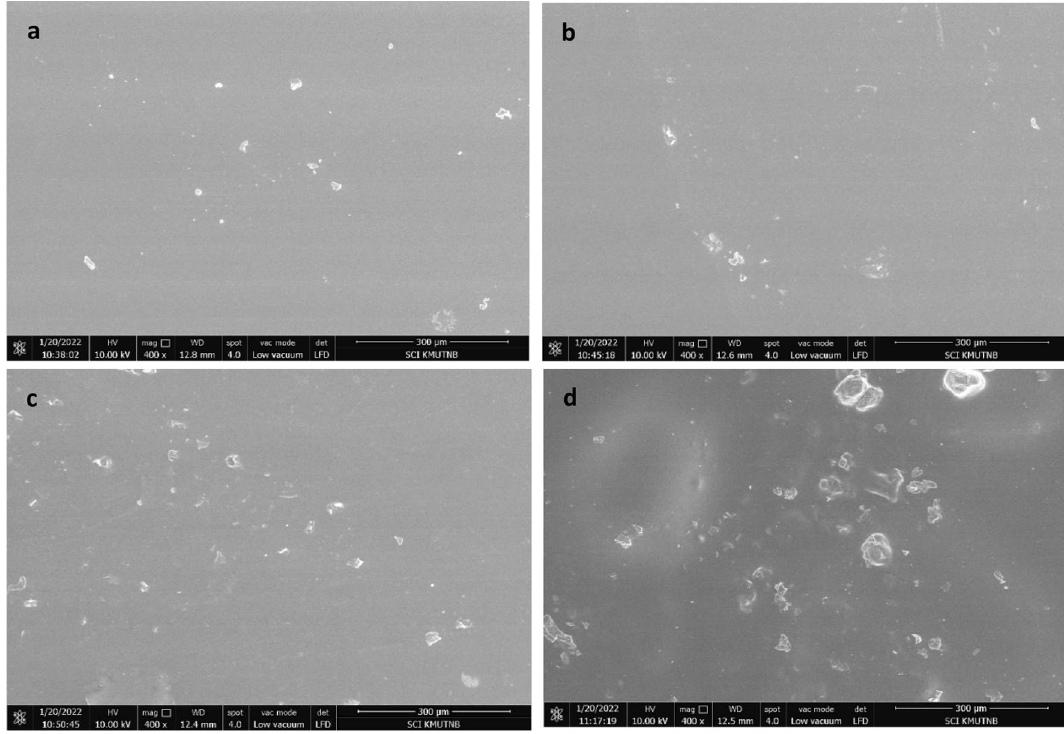
Figure 8. SEM images of PVA/CMC/TUR films: ( a ) PCT-0 ( b ) PCT-1 ( c ) PCT-2 ( d ) PCT-3.